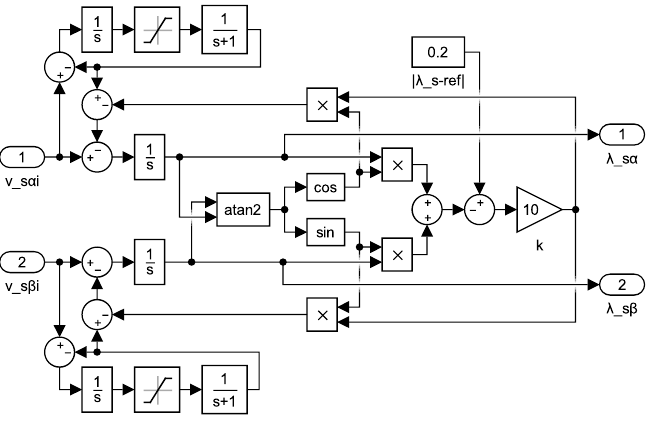
Figure 12. The block diagram of the compensation of the integrational drift by Holtz and Quan presented in [18,19] used for simulations in MATLAB Simulink.